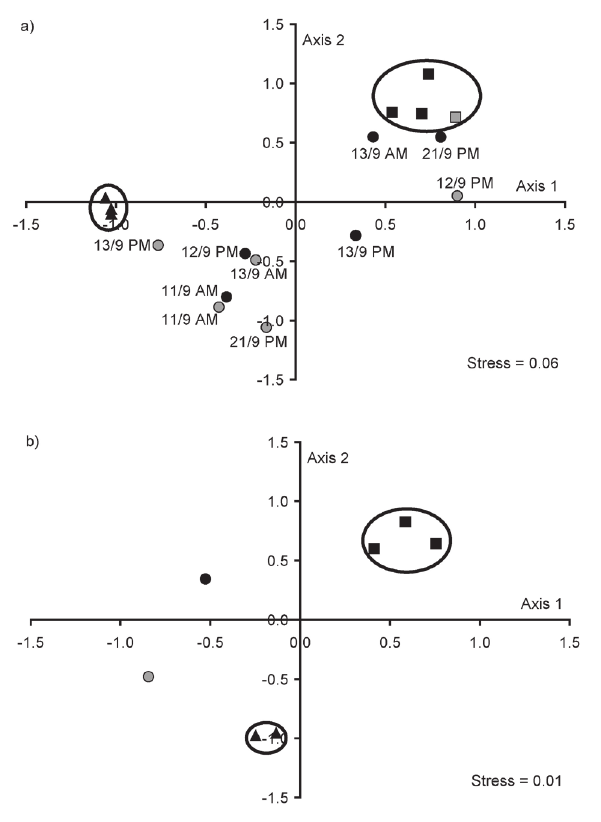
Fig . 3. – results of ordinations using relative fatty acid concentra- tions in samples of seston, Calanus finmarchicus stage V copep- odites, Meganyctiphanes norvegica and Nanomia cara from georg- es basin and oceanographer Canyon. Stress values of less than 0.1 indicate an acceptable representation of the data; a) georges basin, with dates (dd/m) and times of sampling (aM or PM) shown for Nanomia cara : black squares, seston taken during daytime; grey square, seston taken at night; black triangles, Calanus finmarchi- cus stage V copepodites; black circles, Nanomia cara nectosomes; grey circles, Nanomia cara siphosomes; b) oceanographer Canyon: black squares, seston taken at night; black trangles, Meganycti- phanes norvegica ; black circle, Nanomia cara nectosome; open circle, Nanomia cara